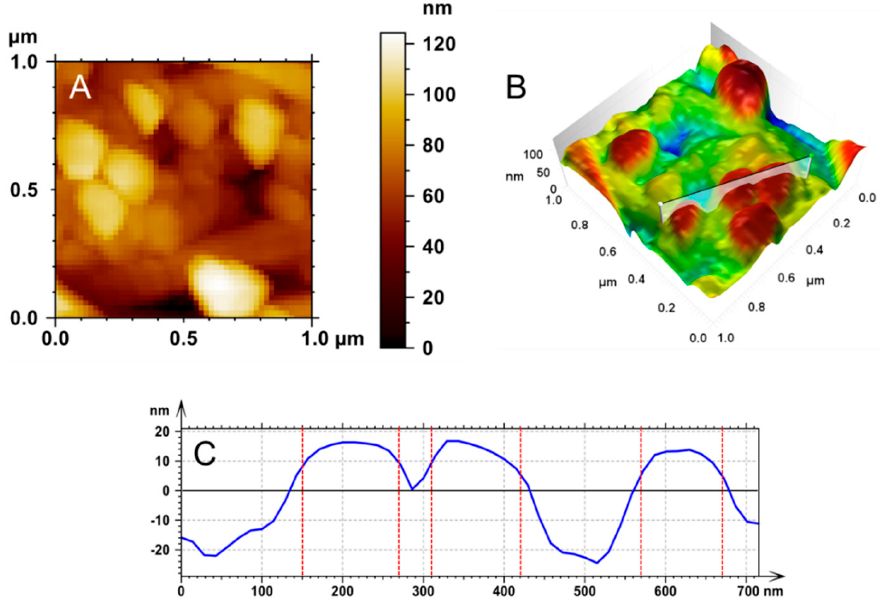
Figure 5. Two-dimensional ( A ) and three-dimensional ( B ) AFM topographic maps of the region of the Bowman’s layer presenting globular structures. The square scan area for all images is 1 × 1 µm. ( C ) A cross-section of the region marked in the image ( B ) shows the profile of three globules with diameters of 120, 110, and 100 nm, taken from the width at half height.